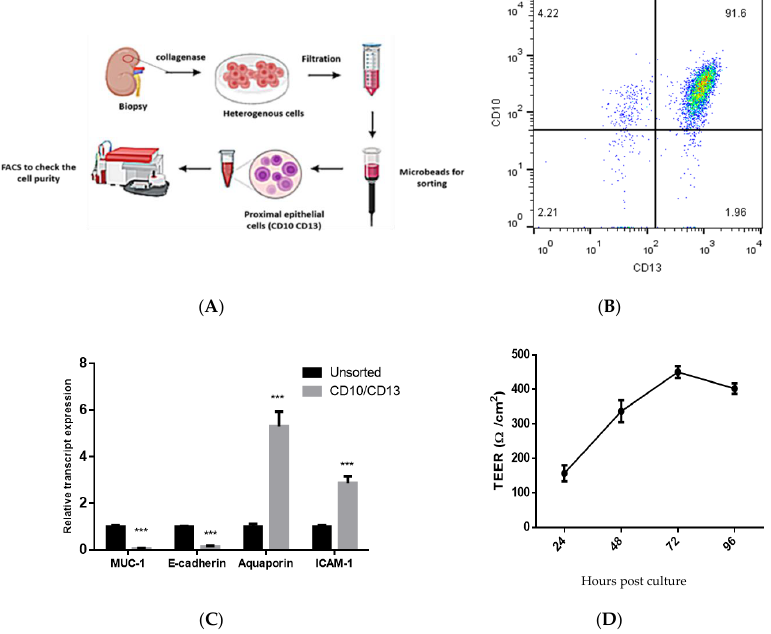
Figure 1. Isolation and characterization of primary human proximal tubular (PT) epithelial cells. ( A ) Schematic flow showing the isolation of PT epithelial cells from a kidney biopsy, and sorting of the cells using microbeads to isolate CD10 + / CD13 + cells. ( B ) The isolated human PT cells were analyzed by flow cytometry to check for purity and the isolated cells were stained with anti-CD10 and anti-CD13. ( C ) The isolated human PT cells were checked for MUC-1, E-cadherin, Aquaporin1, and ICAM-1 mRNA expression by qPCR. Black columns represent unsorted cells, and grey columns represent CD10 + / CD13 + cells. Depicted are the mean values of three independent experiments ± SEM. *** indicates p < 0.001 as determined by student’s t -test. ( D ) Transepithelial electrical resistance (TEER) was measured in the cultured CD10 + / CD13 + PT cells over